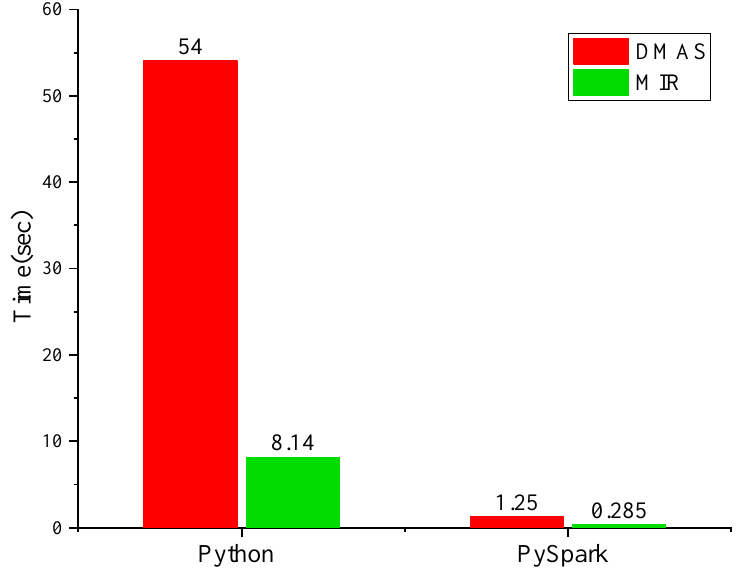
Figure 6. Comparison of the DMAS and MIR algorithms based on DAS proposed in our previous work [34]. The Pyspark improves the performance for both algorithms; however, DMAS takes slightly longer due to multiplication of signal in